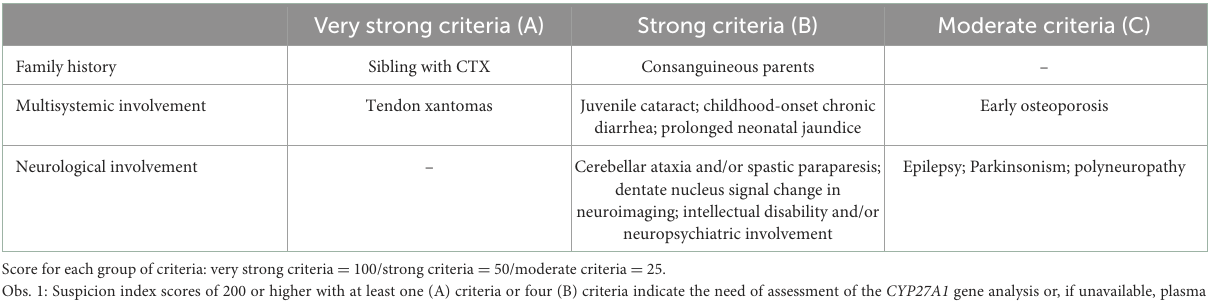
TABLE 1 Mignarri suspicion index for CTX [adapted and modified from